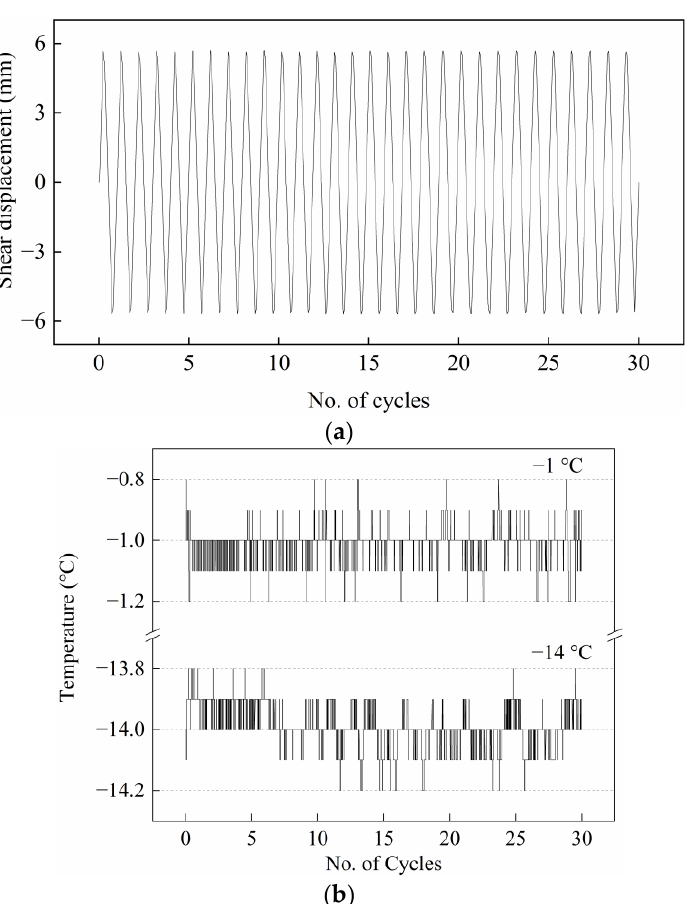
Figure 3. Control validation and accuracy. ( a ) Shear displacement with cyclic loading numbers in direct shear tests; ( b ) frozen cemented soil temperatures measured in constant frozen temperature tests.